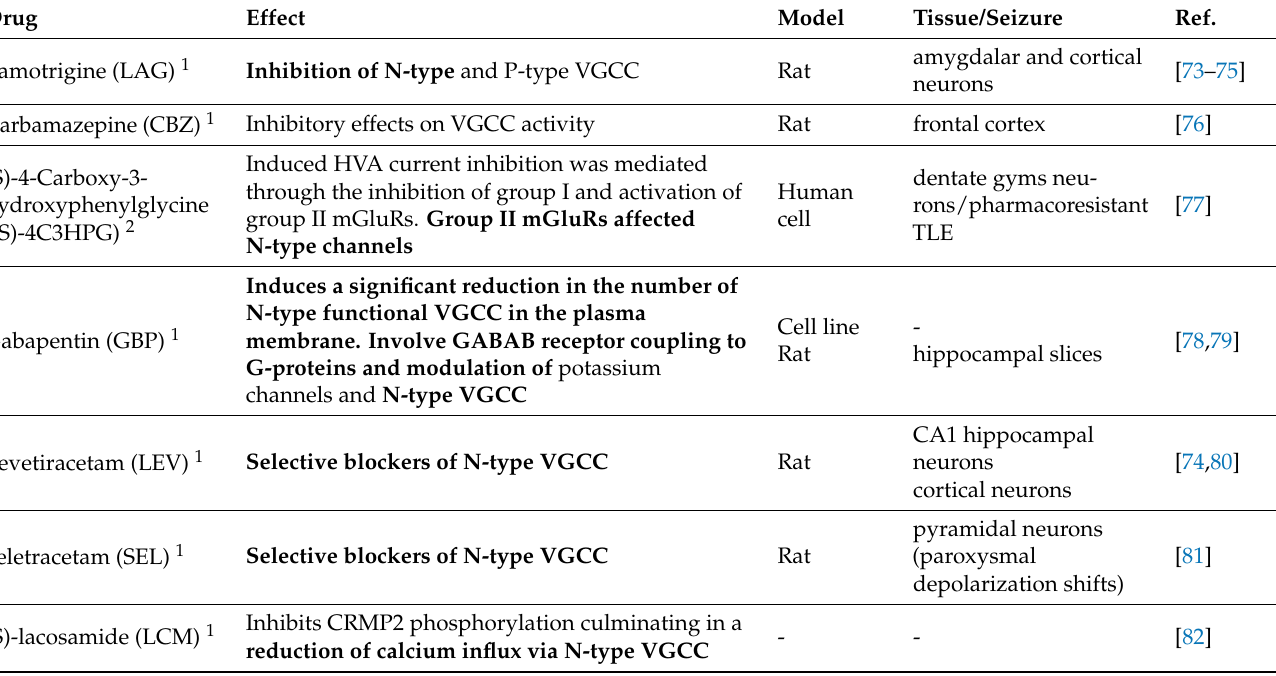
Table 6. Effect of different drugs on N-type Ca